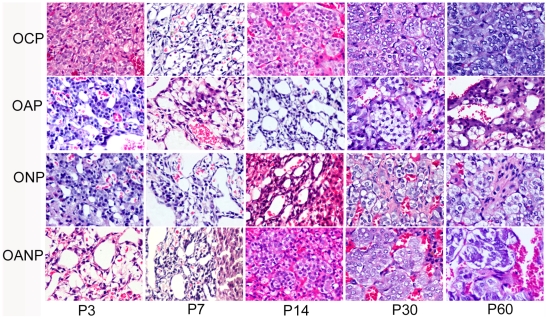
Histopathology examination of adrenal medulla in offspring
rat.P3:postnatal day 3;P7:postnatal day 7; P14:postnatal day 14;
P30:postnatal day 30; P60:postnatal day 60; Adrenal medulla cells showed
cytoplasm edema, some spindle shape chromaffin cells with decreased
particles and a small amount of connective tissue in OAP and ONP rats
from P3 to P60. AMCC decreased and a large number of connective tissues
separated medulla from P3 to P60 in OANP rats. (The magnification of the
image is 400 ×).